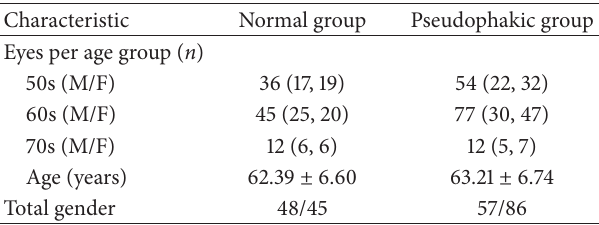
Table1:Characteristicsofnormal( 𝑁 = 93 )andpseudophakic( 𝑁 = 143 ) eyes.